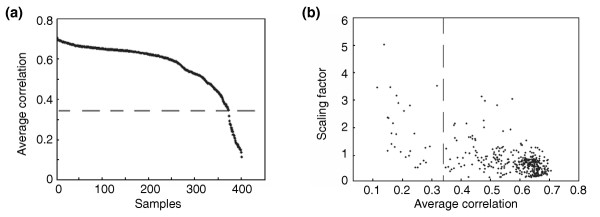
Identification of outlier samples by correlation analysis and scalar factors. (a) Plotting the average correlation for each sample from pairwise comparisons to all other samples (y-axis). The samples were sorted according to their average correlation (x-axis). We used an average correlation of 0.34 as a cutoff (marked with a dashed line). (b) Comparison of the average correlation (x-axis) with the scalar factor used in the global scaling procedure (y-axis). Many of the samples with low average correlations had been rescaled using high scaling factors, indicating that they might have had poor hybridizations. Again, the dashed line displays the average correlation cutoff.